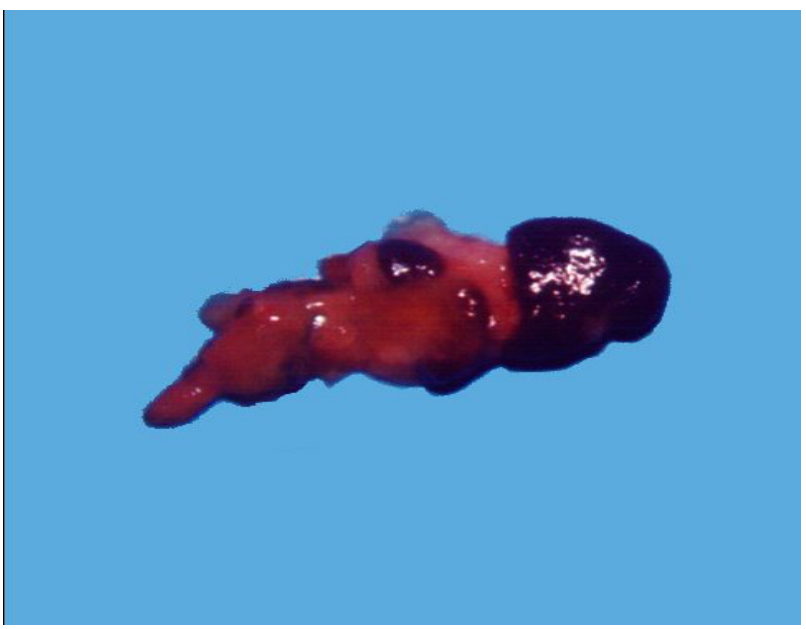
FIGURA 1 - Aspecto macroscópico de auto-implante esplênico regenerado em tecido omental